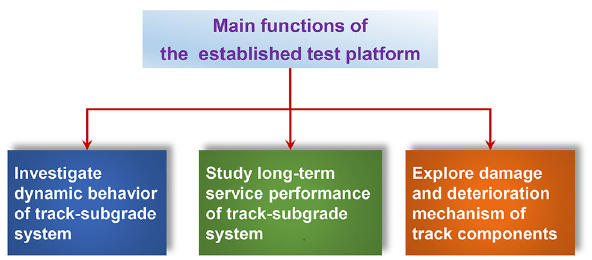
Fig. 15 Main functions of the established